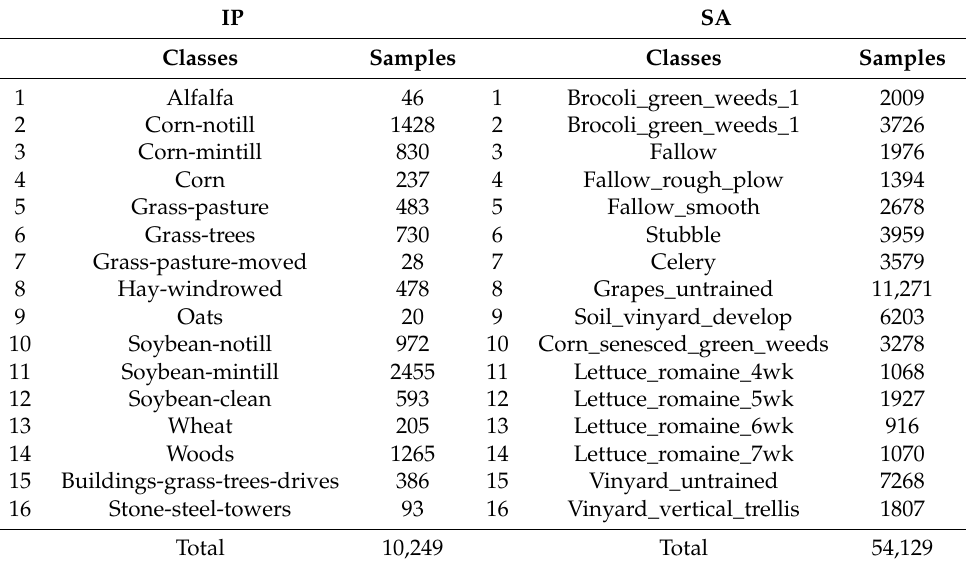
Table 1. Categories and sample numbers of the IP and SA datasets.